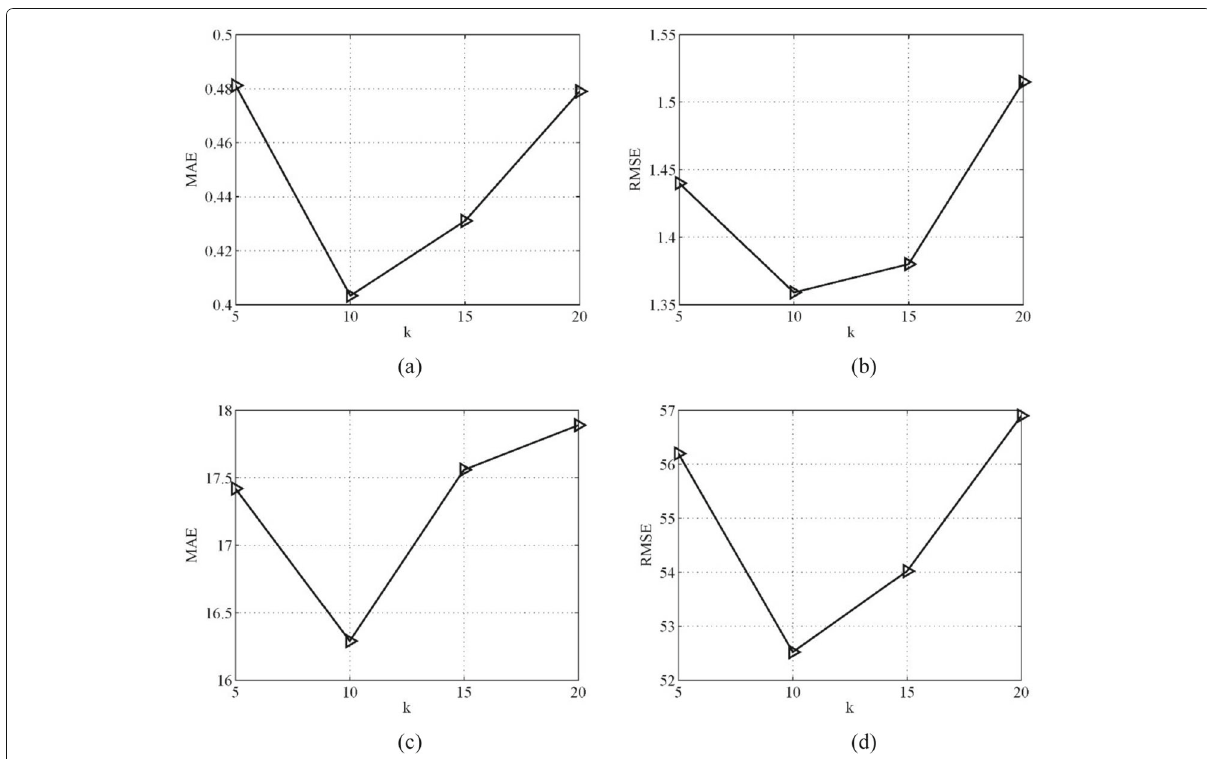
Fig. 3 Impact of k on prediction accuracy